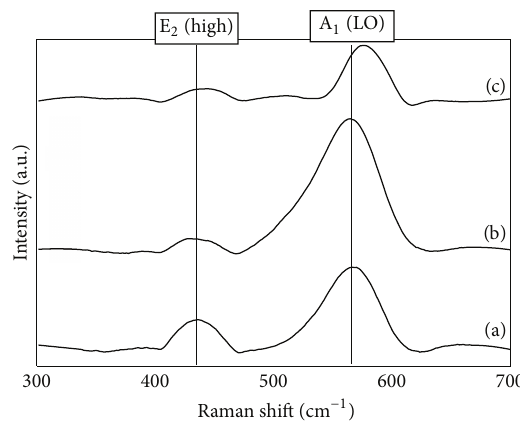
Figure 3: Raman spectra for (a) 1 V, (b) 2V, and (c) 3 V (excitation: 𝜆 = 514